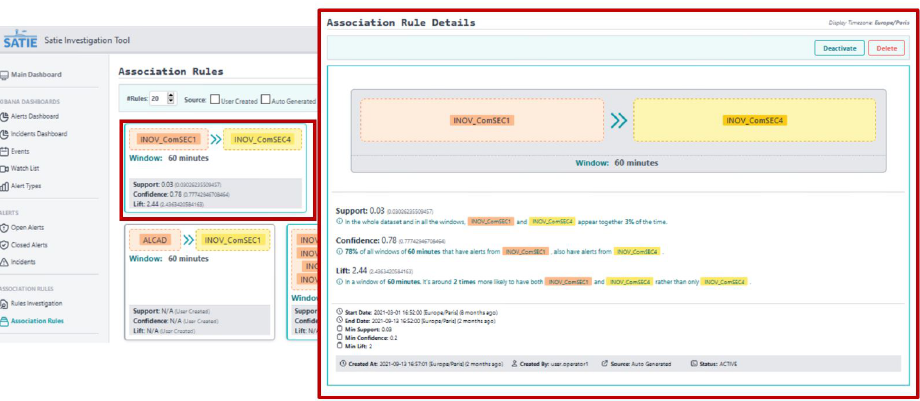
Figure 20. SMS-I Intelligent Dashboard: Association rules visualization.